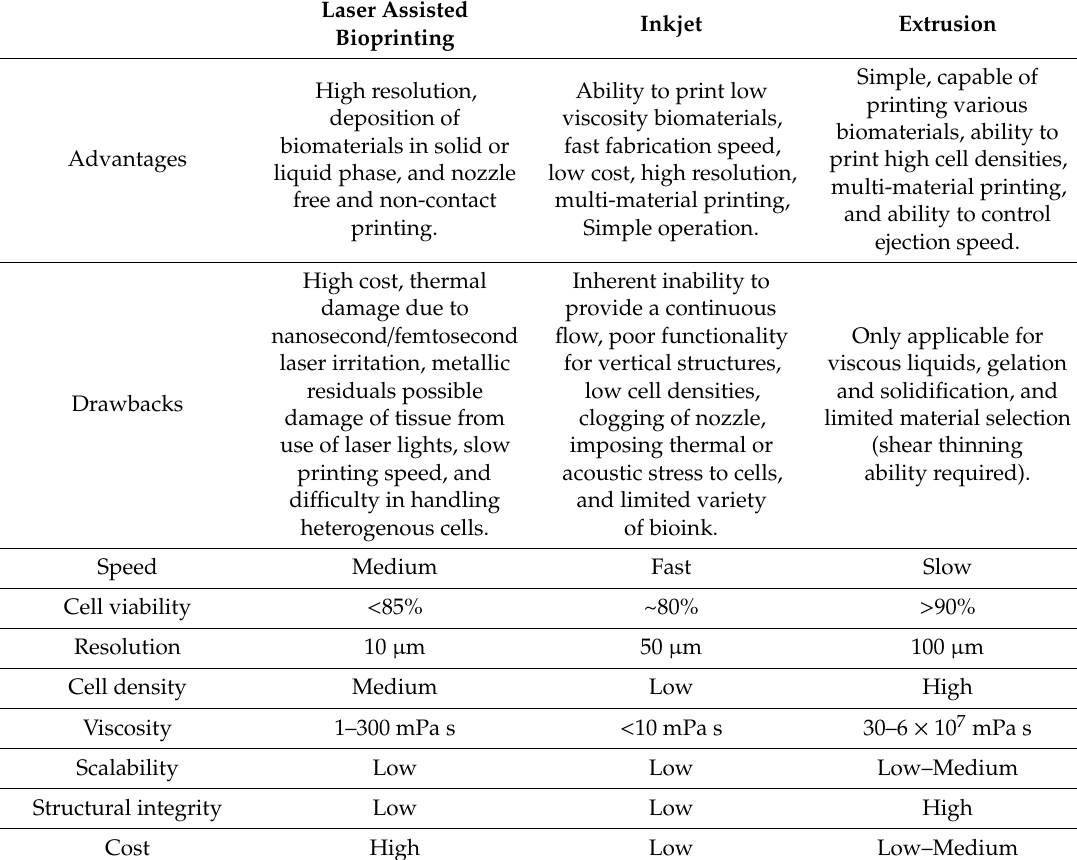
Table 1. A brief review of common bioprinting